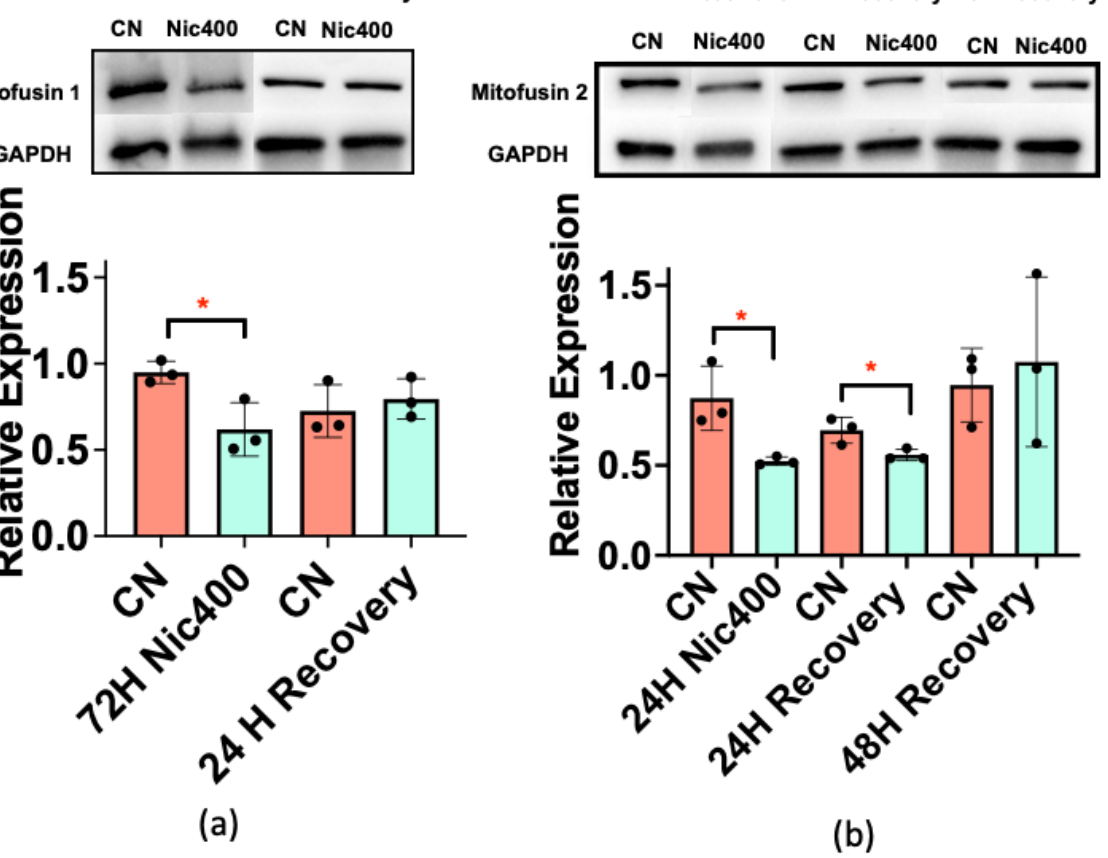
Figure 5. Mitofusin 1/2 protein expression in nicotine treated keratinocytes after 24 and 48 h of recovery. ( a ) Expression of mitofusin 1 in a Western blot after 72 h of exposure to Nic400 and after 24 h of recovery; ( b ) expression of mitofusin 2 after 24 h of exposure to Nic400, followed by 24 and 48 h of recovery. CN = control medium. All data are means ± the standard error of the mean for three independent experiments. * = p < 0.05